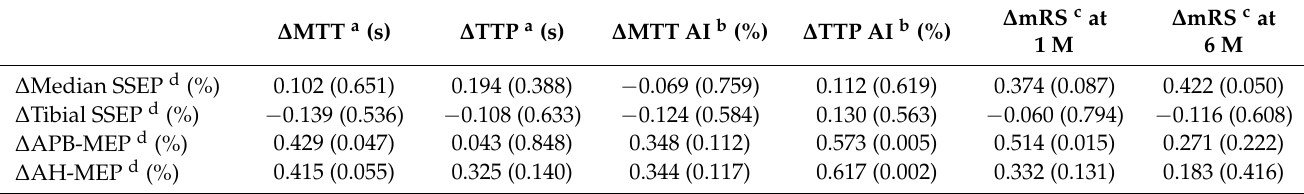
Table 4. Correlation coefficients ( p -value) between EP changes and other examined parameters in the MB group.